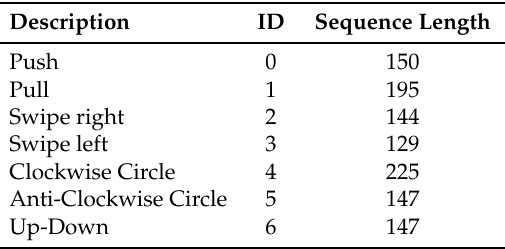
Table 1. The 7 gestures recorded for testing. Their description is provided in the text. The sequence length is given in frames captured by the input